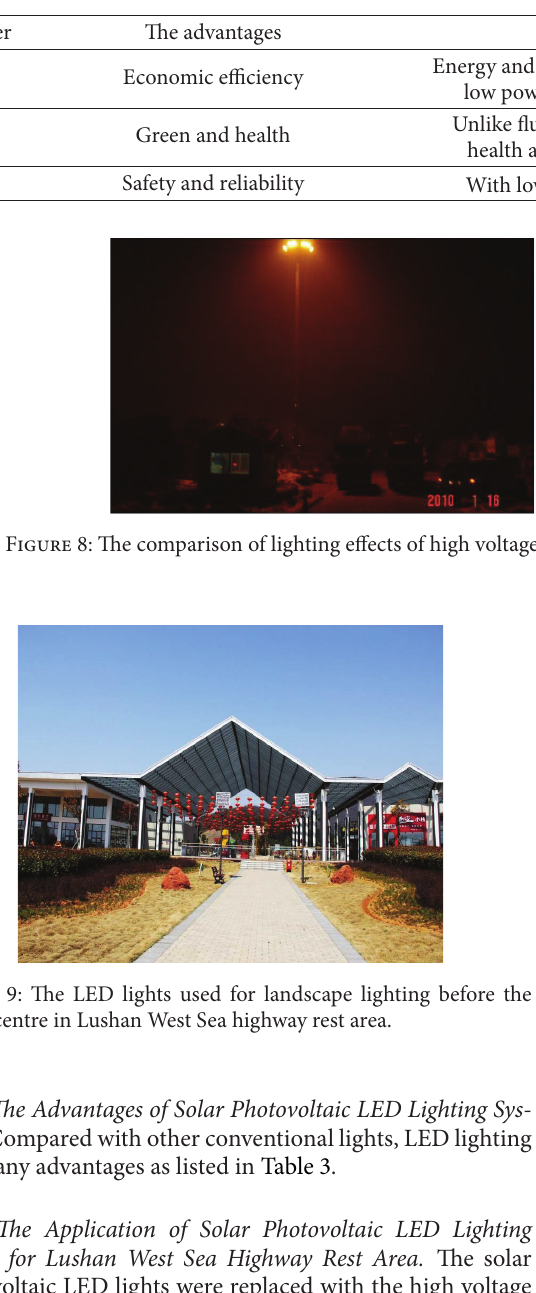
Table 3: The advantages of solar Photovoltaic LED lighting.